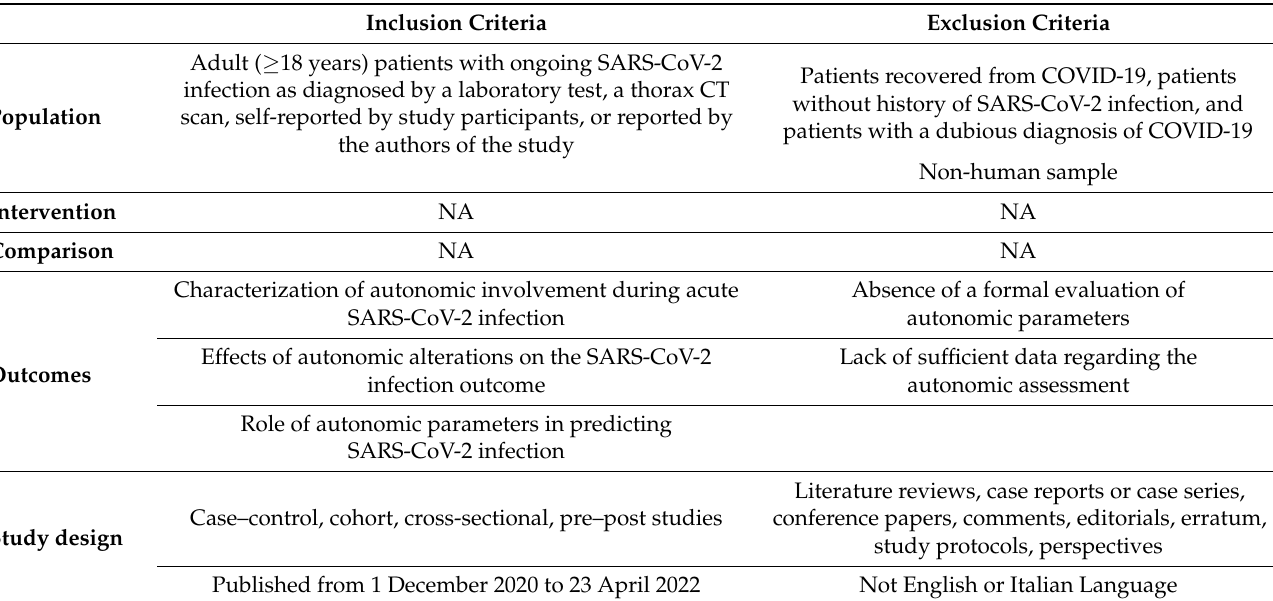
Table 1. Inclusion and exclusion criteria of the systematic review according to